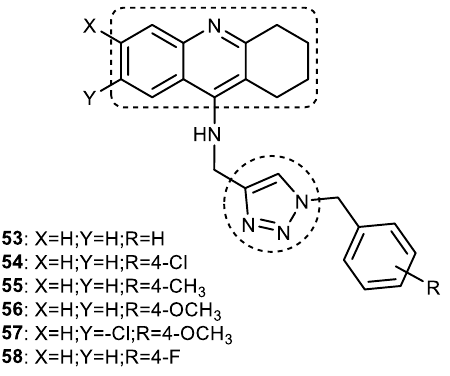
Figure 18. Chemical structure of tacrine – 1,2,3-triazole hybrids.